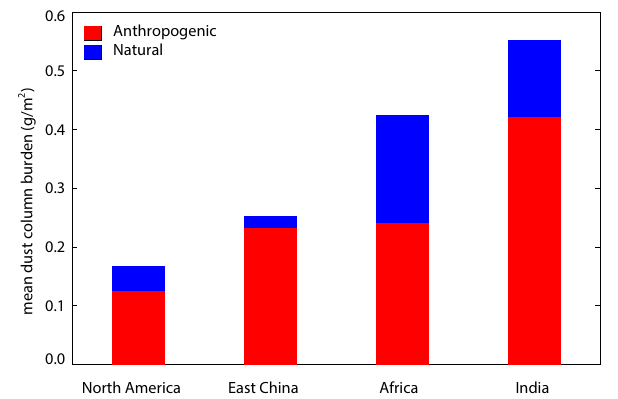
Figure 10. Anthropogenic (red) and natural (blue) mean dust col- umn burdens and percentages in four regions (eastern China, India, North America and